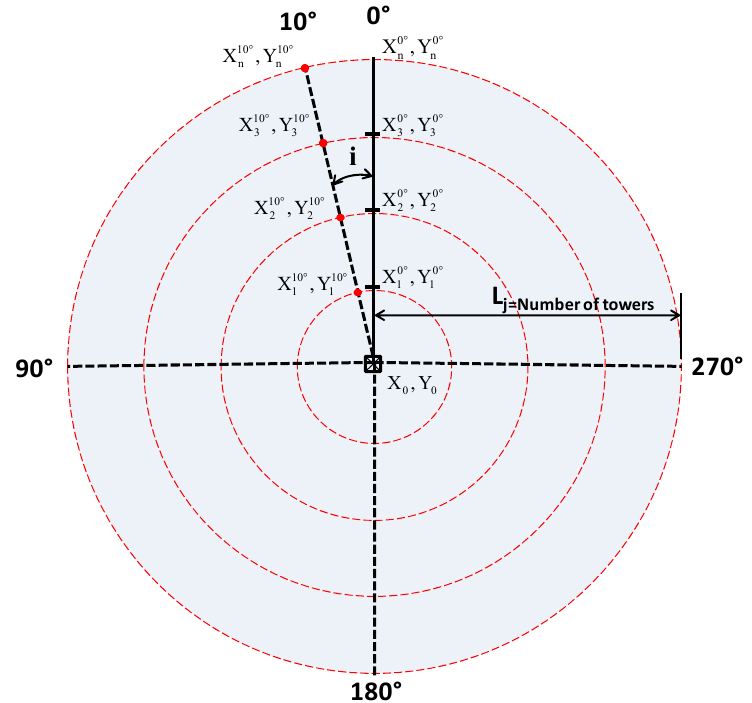
Figure 2. The geographic coordinates during the rotation of the lateral line at the center pivot.